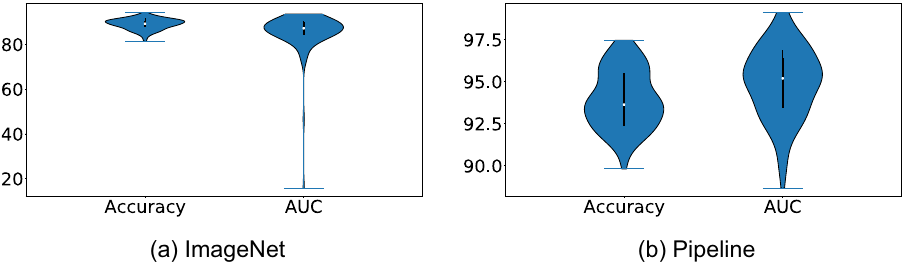
Figure 2. Accuracy and AUC (shown as a percentage) values for DenseNet121 pretrained using ImageNet and CXR datasets. The violin plot is obtained by training and measuring the network performance for 100 times.